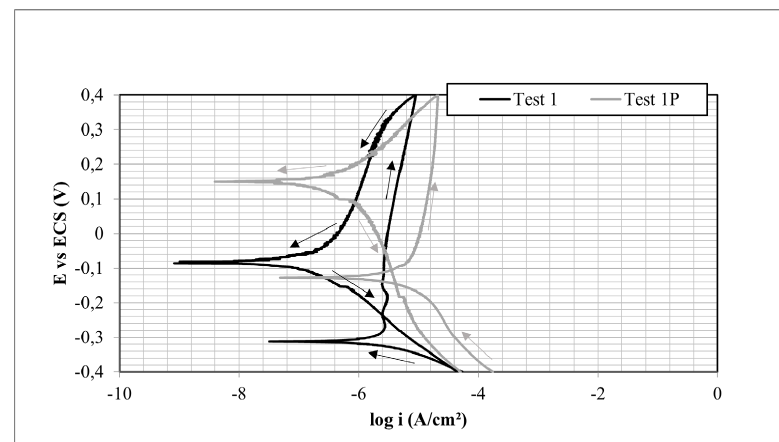
Figure 12. Cyclic voltammetric curves for tests 1 and 1P.